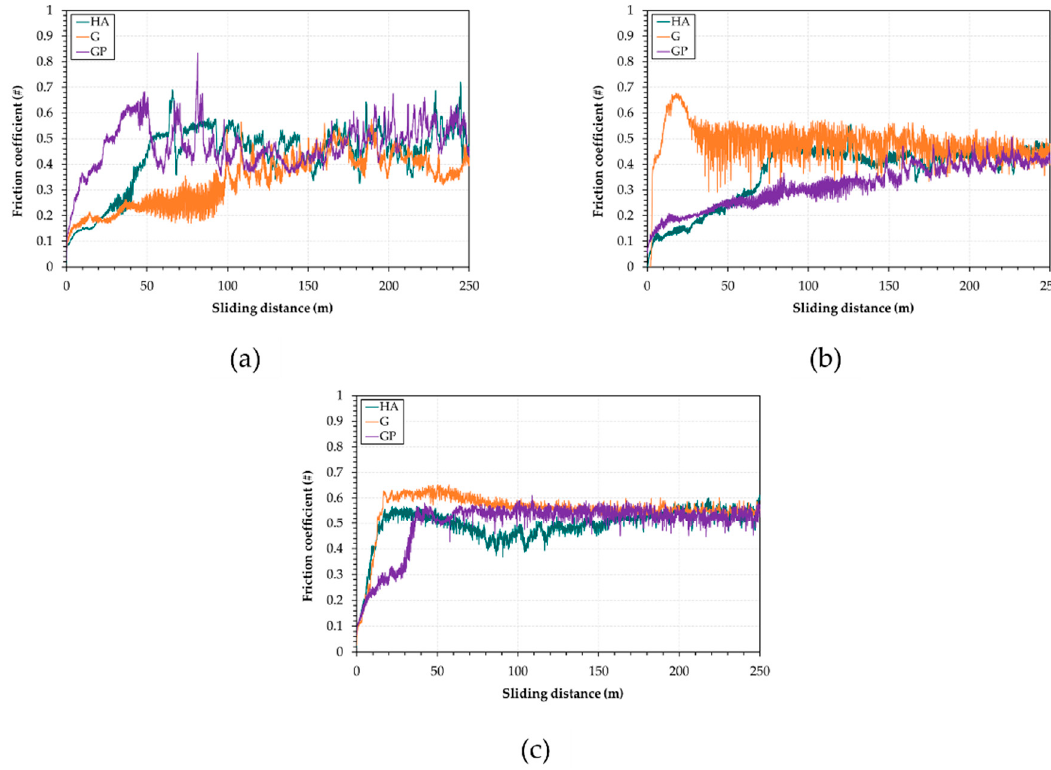
Figure 7. Friction coefficient variations calculated during the tests for the different anodizing treatments and for thicknesses of AAO layers of ( a ) 25 μ m; ( b ) 50 μ m; ( c ) 100 μ m.